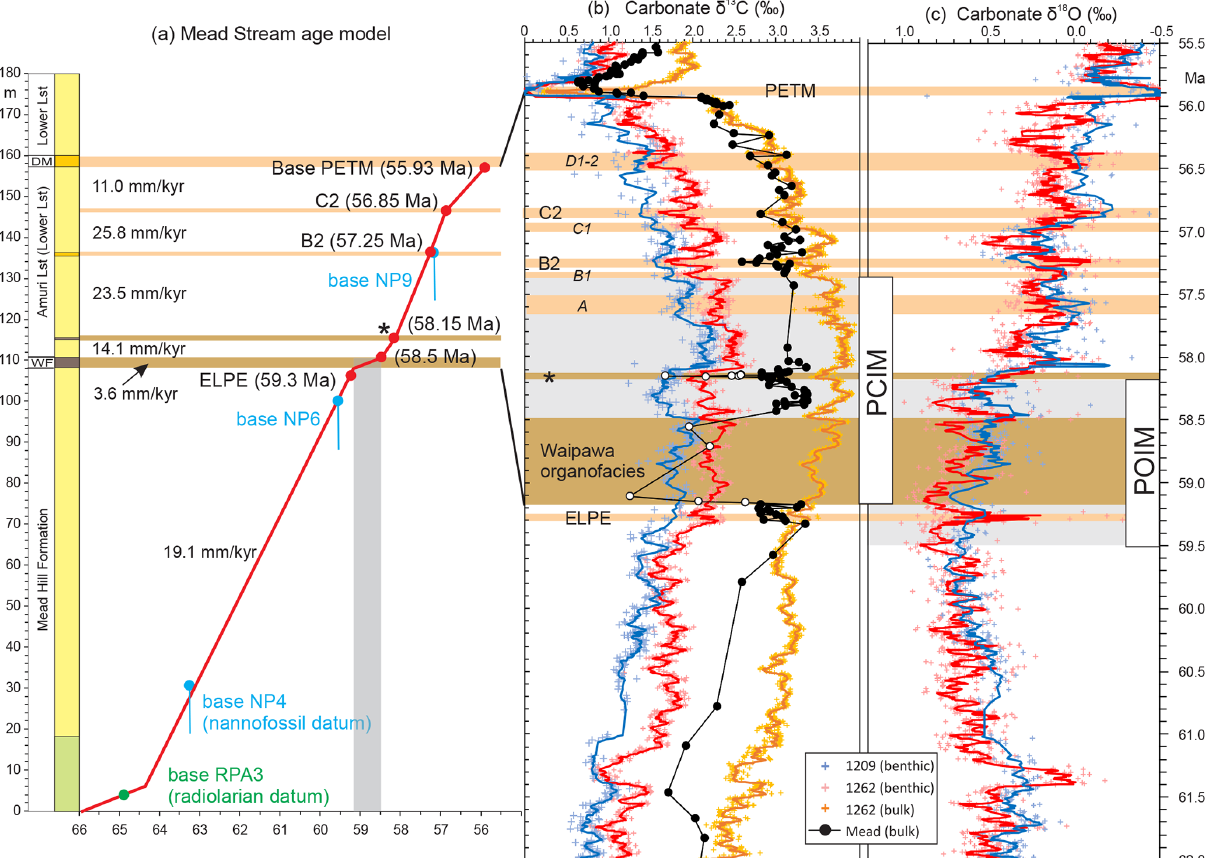
Figure 13. Revised age range for Waipawa organofacies based on (a) an age model for Paleocene sediments at Mead Stream (biostratigraphy after Hollis et al., 2020) and (b) correlation with high-resolution bulk carbonate and benthic foraminiferal (b) δ 13 C and (c) δ 18 O records from North Pacific ODP Site 1209 and South Atlantic ODP Site 1262 (Barnet et al., 2019; Westerhold et al., 2020). Stable isotope correlation of the Paleocene section at Mead Stream utilizes five carbon isotope excursions (CIEs) as tie points: ELPE, the unnamed “*” event at 58.15Ma, B2, C2 and the PETM (Table S7). White filled circles in the Mead δ 13 C record are considered unreliable due to low carbonate content ( < 5wt%). Isotope curves for ODP sites are five-point moving